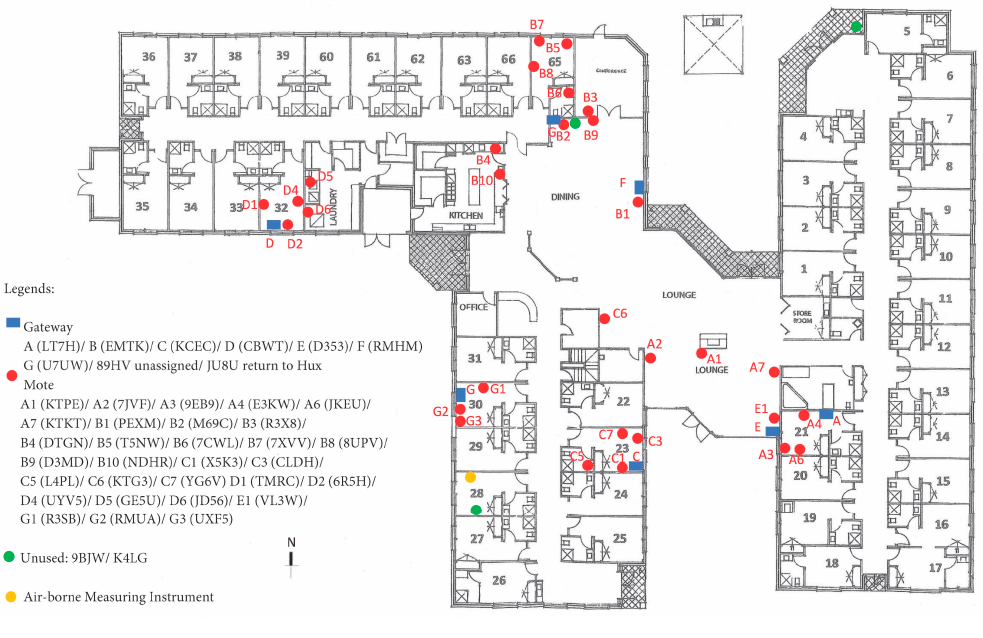
Figure 5. Locations of Indoor Environmental Quality (IEQ) Measurements. Buildings 2018 , 8 , x FOR PEER REVIEW